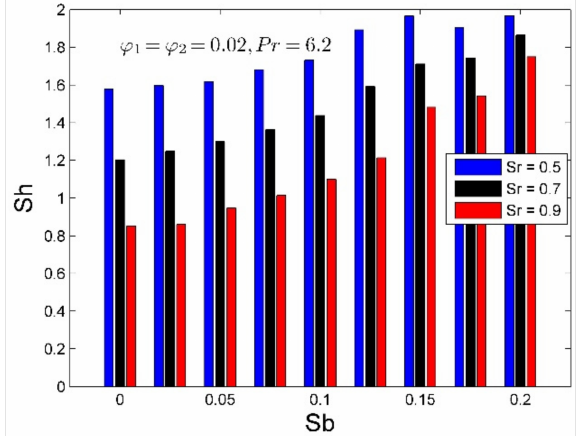
Figure 10. Influences of Sr on Sh